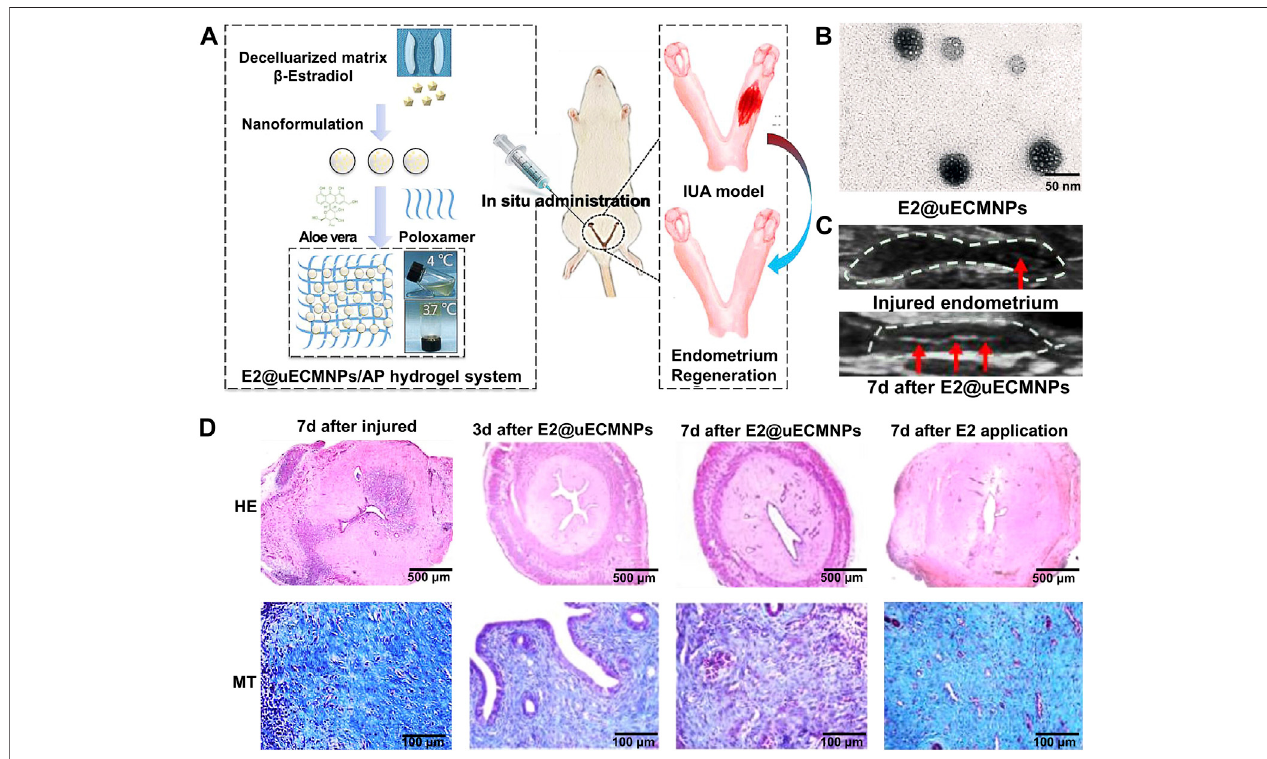
FIGURE 1 | An overview of E2@uECMNPs/AP hydrogel system with multi-therapeutic effects to promote endometrial regeneration for the prevention of IUA. (A) Schematic graphs of E2@uECMNPs/AP hydrogel system. (B) TEM images of E2@uECMNPs. (C) Comparison of ultrasound images of the injured endometrium with or without E2@uECMNPs treatment. (D) H&E staining (HE) and Masson staining (MT) of the uterus from IUA rat ’ s uteri and IUA rats uteri receiving different treatments on day 3 and 7 after injury. Reproduced with permission (Yao et al., 2020). Copyright 2020, Elsevier